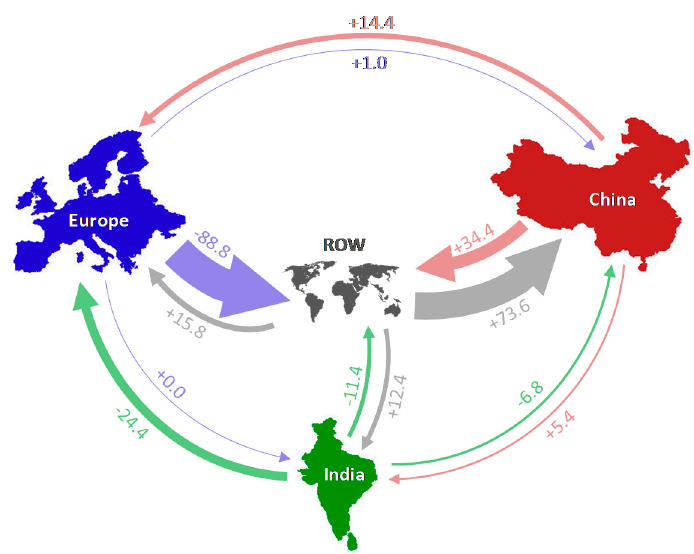
Figure 8. Change in total export flows between Europe, China, India and rest of the world (ROW) for low carbon technology scenario relative to baseline in billion USD.